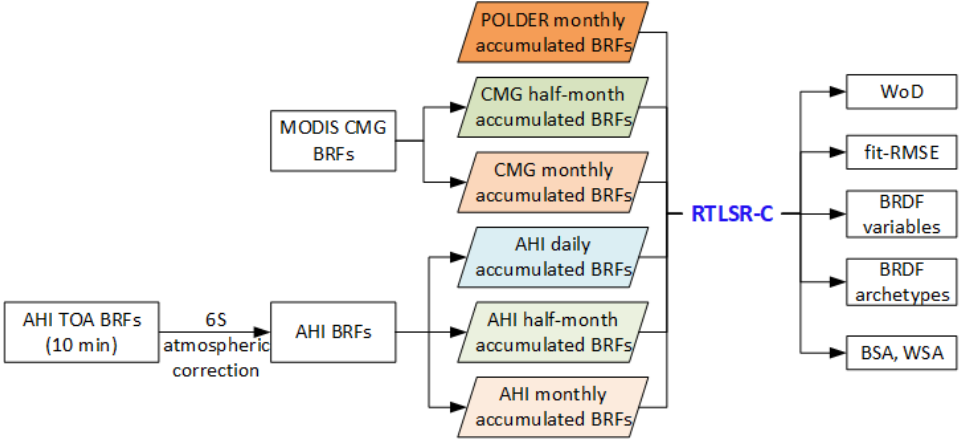
Figure 4. Flowchart for evaluating the BRDF information of time-series AHI data.